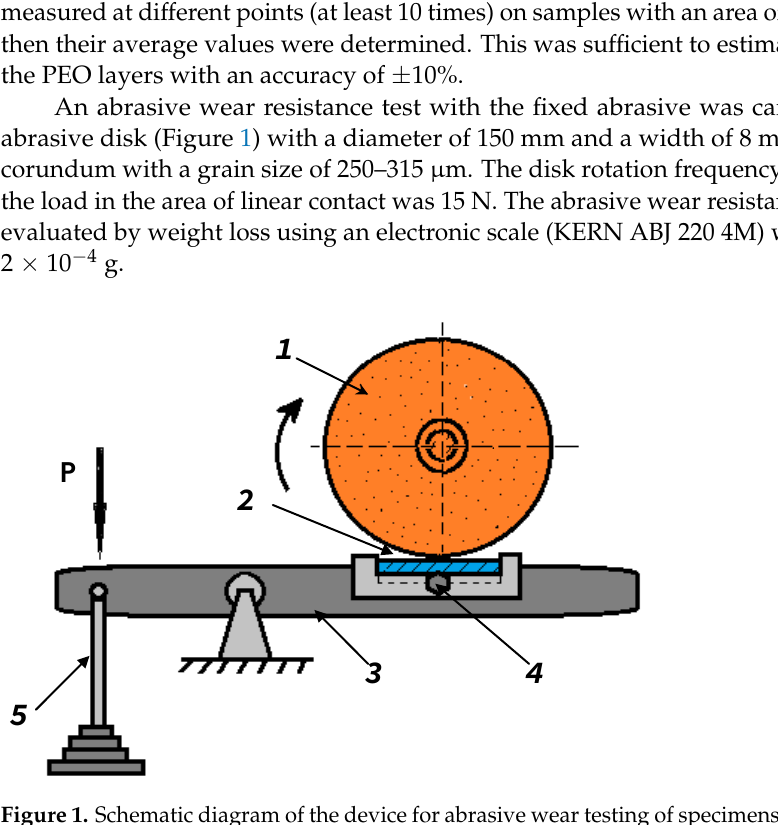
Figure 1. Schematic diagram of the device for abrasive wear testing of specimens with PEO layers synthesized on their surface: 1—abrasive wheel; 2—specimen; 3—lever transmitting force; 4—specimen fixation elements; 5—weights; P — load.